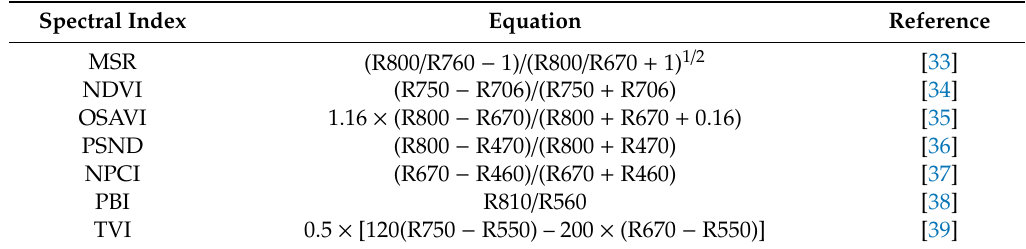
Table 1. The spectral indices used in this